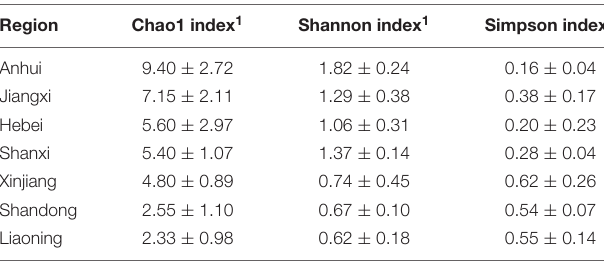
TABLE 2 | Alpha diversity indexes of pollen